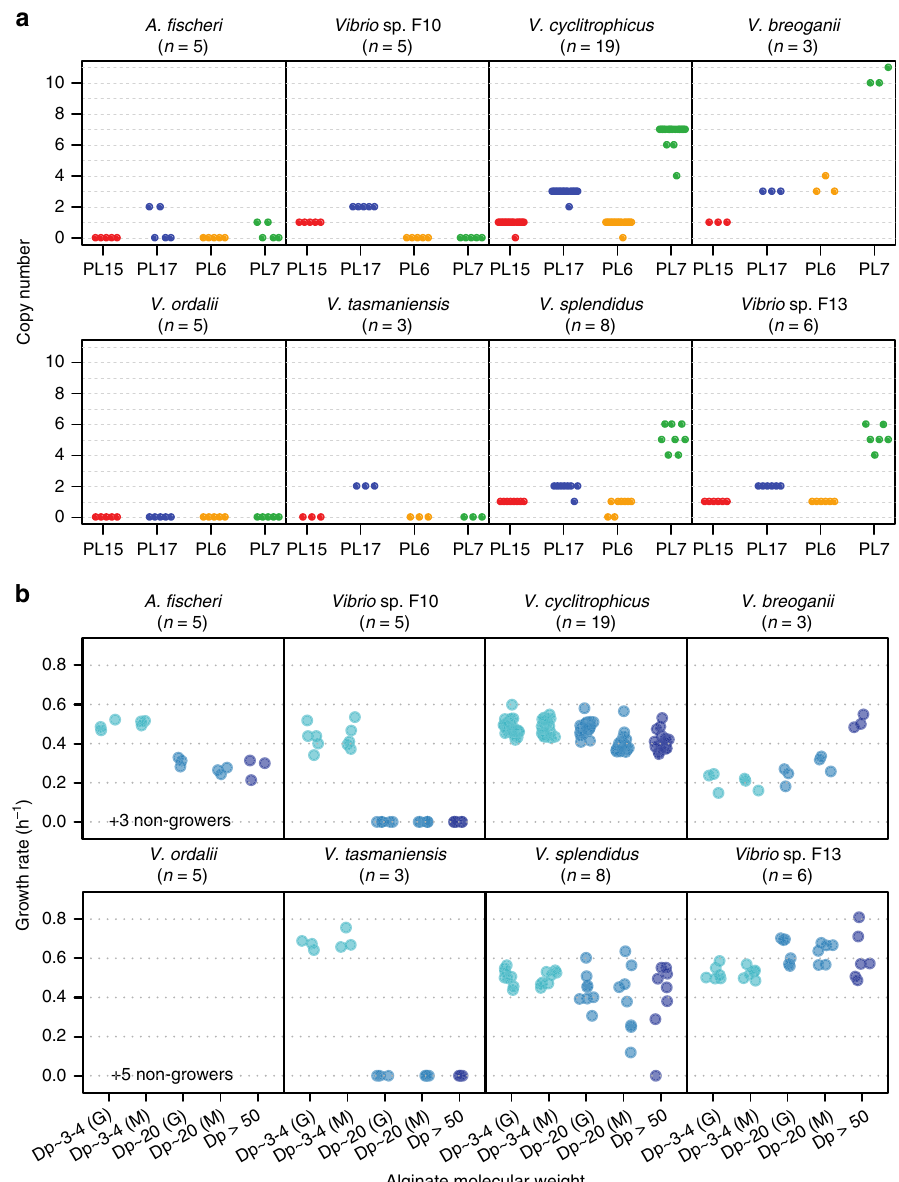
Figure 3 | Growth rates on alginate substrates of different chain length and solubility. ( a ) Alginate lyase (PL6, orange; PL7, green) and oligoalginate lyase (PL15, red; PL17, blue) copy number for individual strains within populations of Vibrionaceae . ( b ) Isolates representing different populations were grown in seawater minimal medium containing low- (Dp B 3–4, aqua), medium- (Dp B 20, blue), or high- (degree of polymerization, Dp 4 50, dark purple) molecular weight alginate as the sole carbon source. Since alginate is a heteropolymer of guluronate and mannuronate, the low and medium molecular weight alginate was further purified into guluronate (G)- or mannuronate (M)-enriched fractions. Each dot represents the average growth rate of an isolate from the denoted population on the designated carbon source across three technical replicates. The number of isolates assayed per population ( n ) is